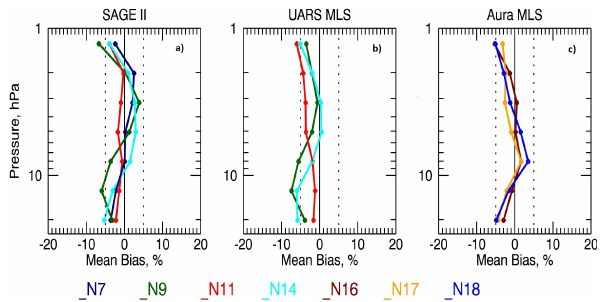
Fig. 5. Vertical profiles of mean biases relative to (a) SAGE II, (b) UARS MLS and (c) Aura MLS for the latitude band 50 ◦ S–50 ◦ N. Colors correspond to individual SBUV